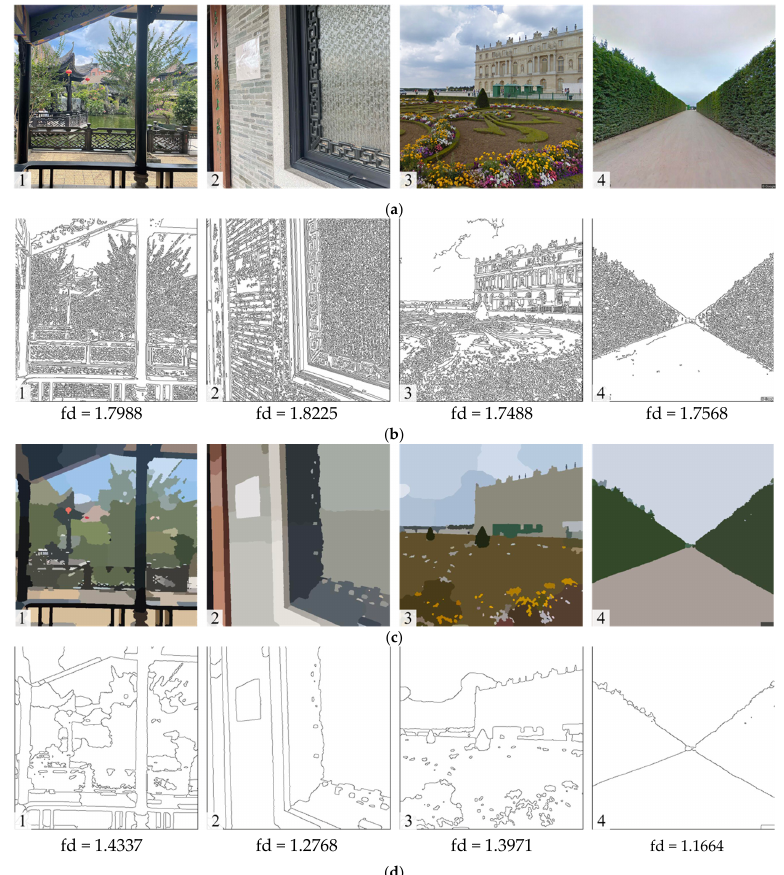
Figure 3. The comparison between the standard fractal dimension method and the proposed FDH method. ( a ) original images, listed as ( a1 – a4 ) from left to right; ( b ) Canny edge detection of the original images in the FDT method and their corresponding fractal dimension (fd); ( c ) Potts segmentation ( γ = 0.8) of the original images in the proposed FDH method; ( d ) Canny edge detection after Potts segmentation in the proposed FDH method and their corresponding fractal dimension (fd).